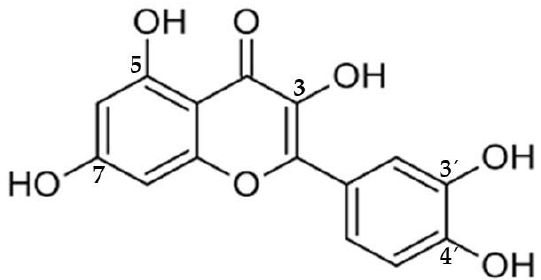
Figure 1. Chemical structure of QR with 15 carbon atoms arranged in three rings